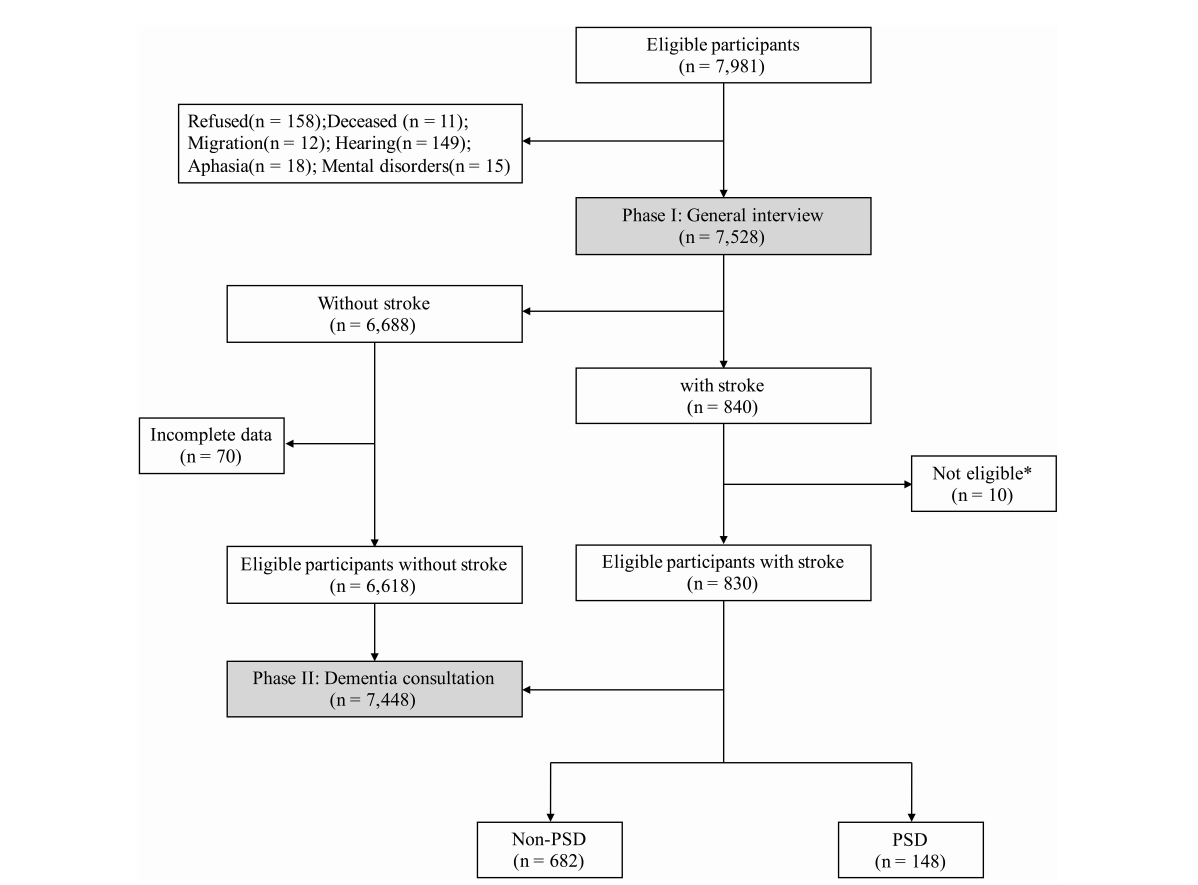
FIGURE1 Flowchart of this study. * Not eligible: within 6 months after stroke ( n = 5); dementia before first-ever stroke ( n = 2); severe stroke or massive cerebral infarction/hemorrhage ( n = 3).